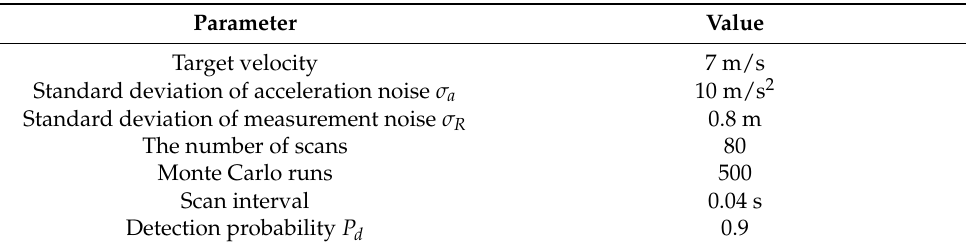
Table 3. Simulation Parameters.